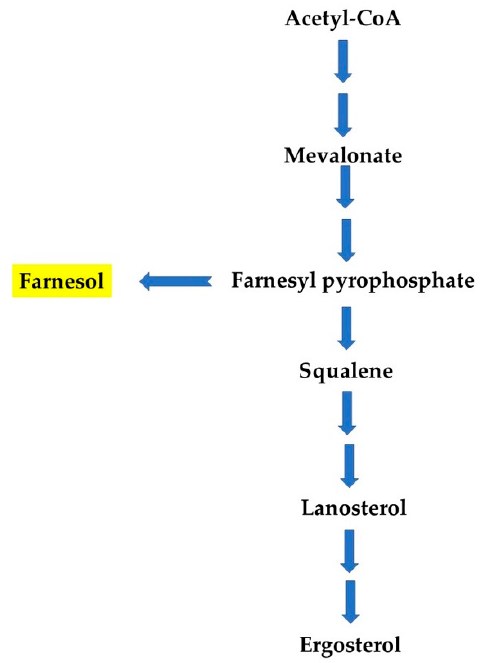
Figure 3. Far synthesis from a metabolic intermediate of ergosterol biosynthesis pathway, farnesyl pyrophosphate (according to References [22,23]).